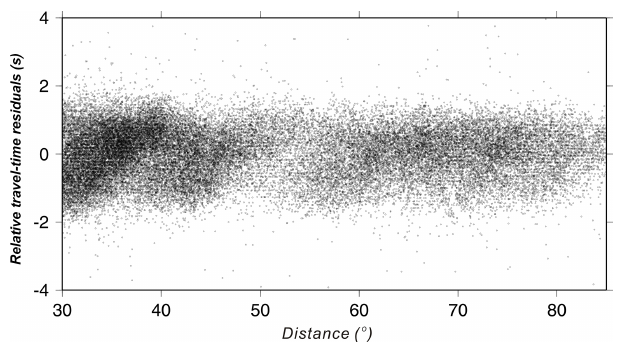
Figure 3. Distribution of relative travel-time residuals. We limited it to between > − 2s and < 2s for the tomographic inversion.